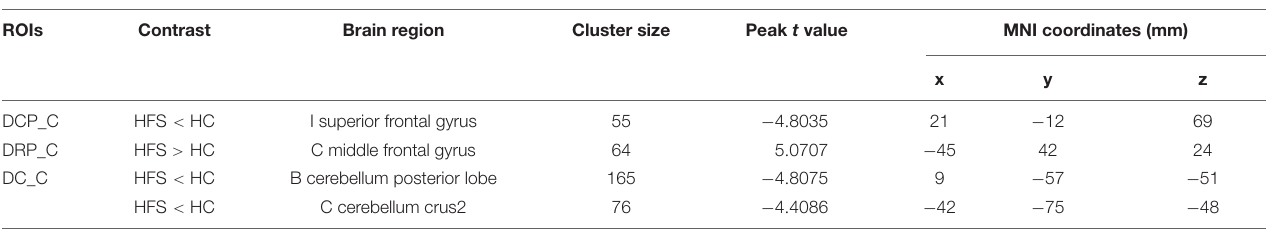
FIGURE 4 | Altered FC in the cortical-striatal network. Boxplots with between-group differences for 13 significant cluster. In the HFS group compared with the HC group: (A) The FC between contralateral DCP and ipsilateral SFG was decreased. The FC between contralateral DRP and contralateral MFG was increased. The FC between contralateral DC and bilateral cerebellum was decreased. (B) The ipsilateral VSi showed increased FC with bilateral OFC and SMA. The FC between ipsilateral VSi and ipsilateral SMG was decreased. (C) The FC between contralateral VSi and bilateral OFC was increased. The FC between contralateral VSi and ipsilateral SOG was decreased. The FC between ipsilateral VSs and bilateral SMA was increased. The FC between contralateral VSs and ipsilateral SOG was increased. FC, functional connectivity; HFS, hemifacial spasm; HC, healthy control; C, contralateral; I, ipsilateral; B, bilateral; DCP, dorsal caudal putamen; SFG, superior frontal gyrus; DRP, dorsal rostral putamen; MFG, middle frontal gyrus; DC, dorsal caudate; Cereb, cerebellum; VSi, inferior ventral striatum; OFC, orbitofrontal cortex; SMA, supplementary motor area; SMG, supramarginal gyrus; SOG, superior occipital gyrus; VSs, superior ventral striatum. TABLE 2 | Altered FC in the putamen and caudate ROIs between two groups.